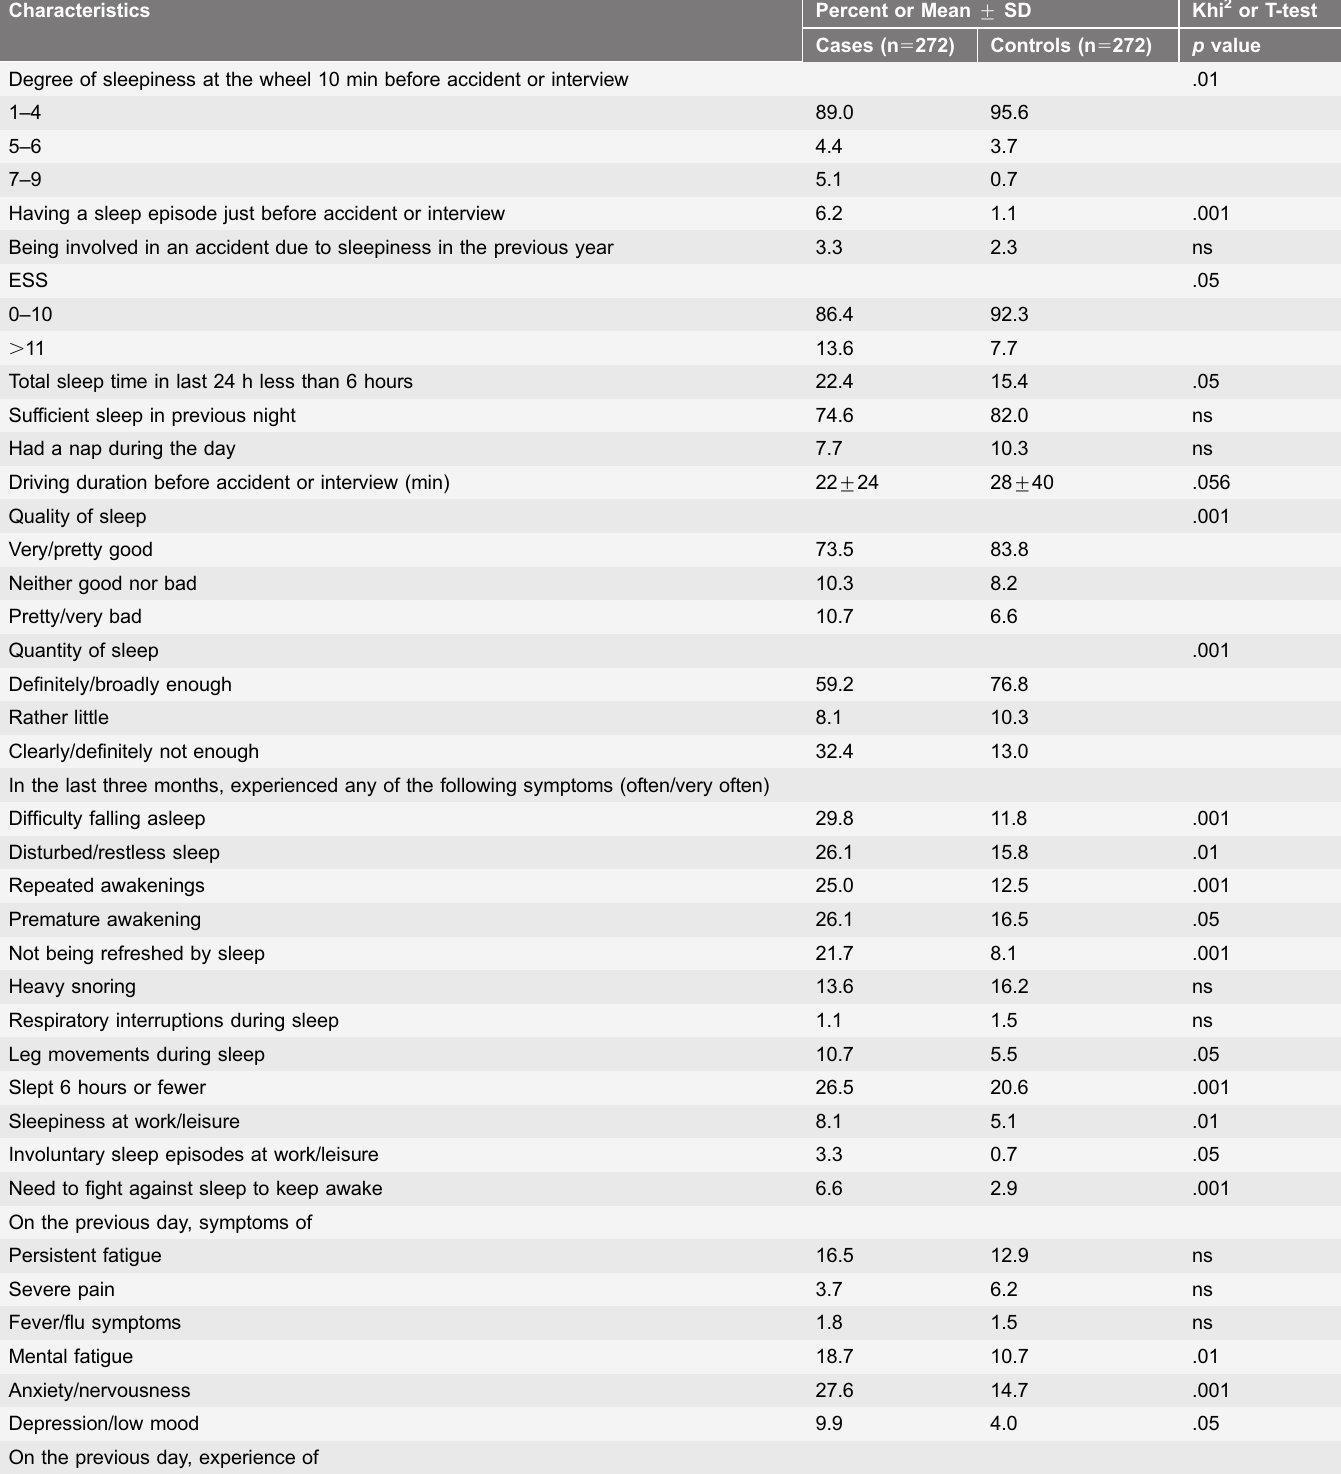
Table 2. Sleepiness assessment, symptoms of sleep disorders, psychiatric symptoms, medication consumption and driving conditions for cases (i.e., drivers admitted to emergency unit at hospital) and controls (i.e., drivers interviewed during road checks carried out by the police).